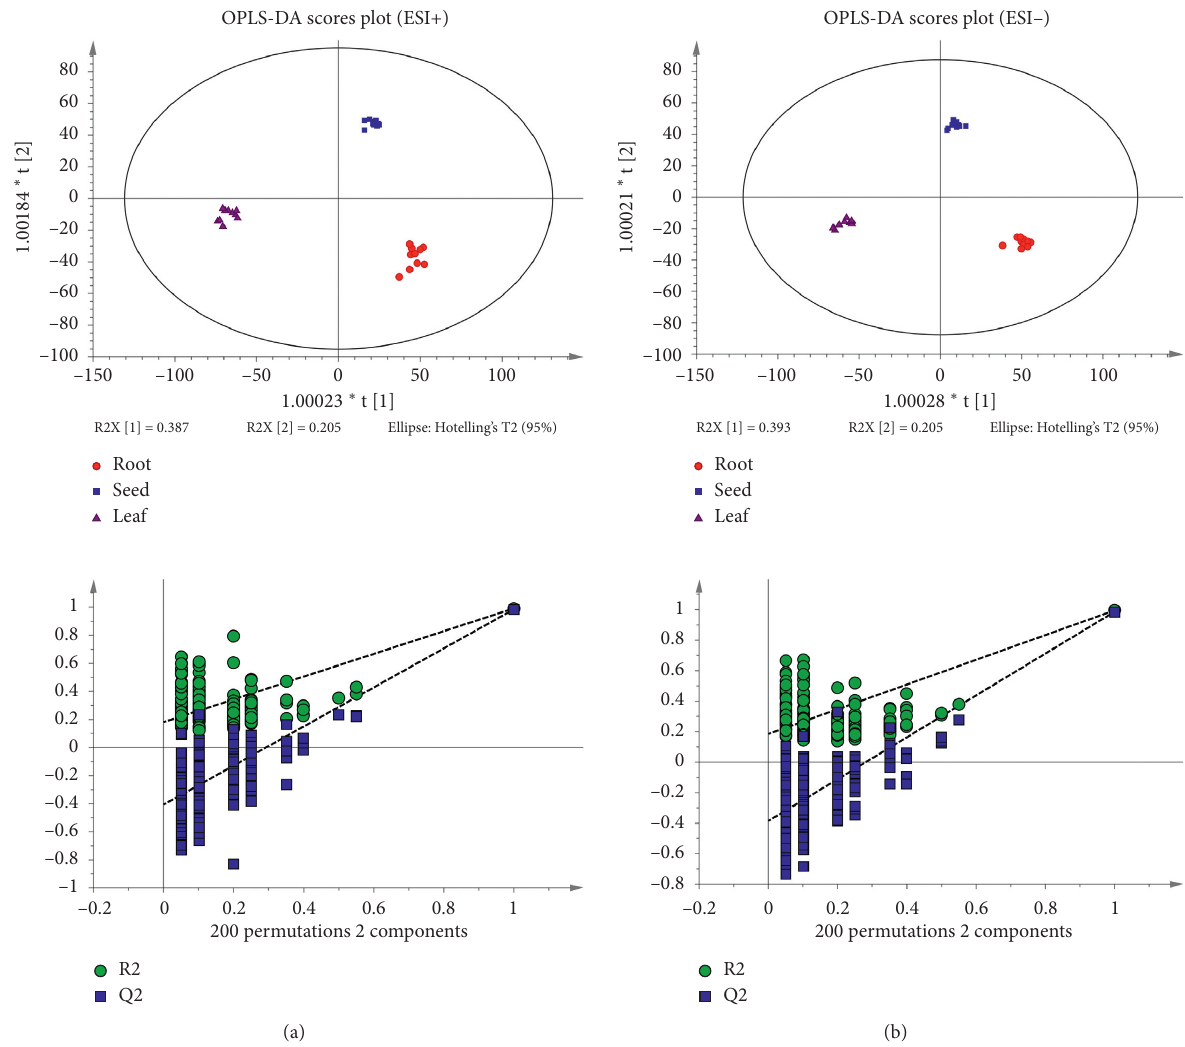
Figure 2: OPLS-DA and permutation score plots of the roots, seeds, and